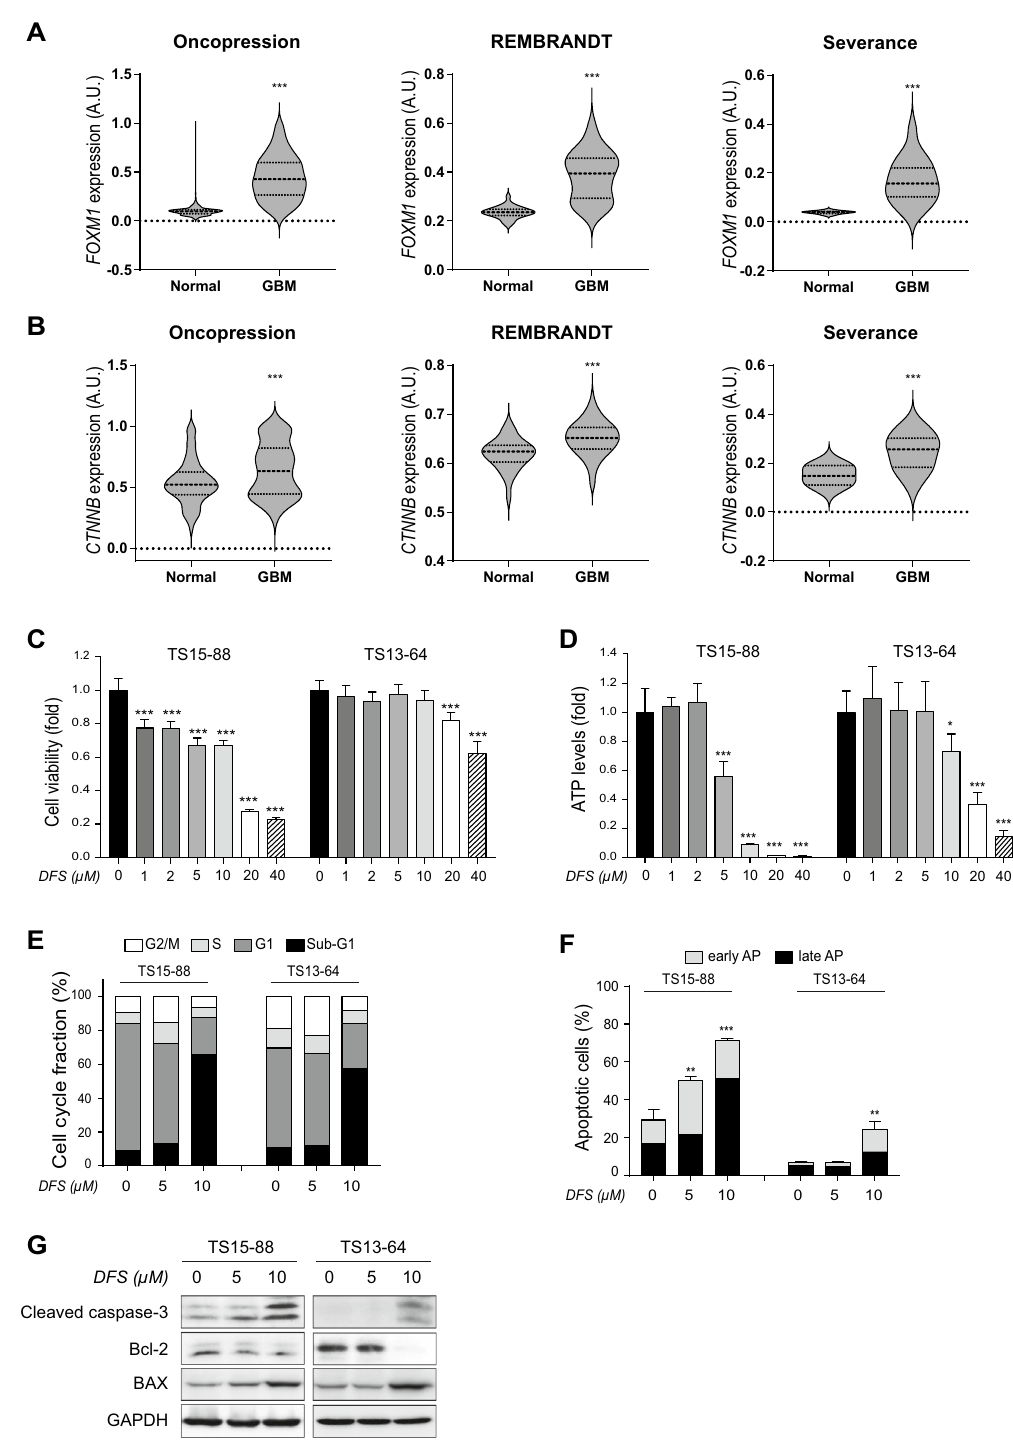
Figure 1. Expression of FOXM1 and β-catenin mRNAs and proteins in GBM tissues and inhibitory effects of DFS on cell survival. ( A , B ) Levels of expression of ( A ) FOXM1 and ( B ) β-catenin (CTNNB1) mRNAs and comparison with public datasets. 865 GBM tissues and 723 normal brain tissues in the dataset of Oncopression, while 228 GBM tissues and 28 normal brain tissues in the dataset of REMBRANDT. ( C ) Cell viability and ( D ) ATP levels measured after 72 h of treatment with the indicated concentrations of DFS. Results are expressed as the means ± SD (n = 5). ( E , F ) GBM TSs were treated with DFS for 72 h, and ( E ) cell cycle fractions and ( F ) apoptotic cell populations analyzed by FACS. ( G ) Expression of apoptosis-associated proteins measured by western blotting after treatment with DFS for 72 h. Differences among groups were compared by one-way ANOVA with Tukey’s post hoc test for multiple comparisons; *P < 0.05, **P < 0.01, ***P <